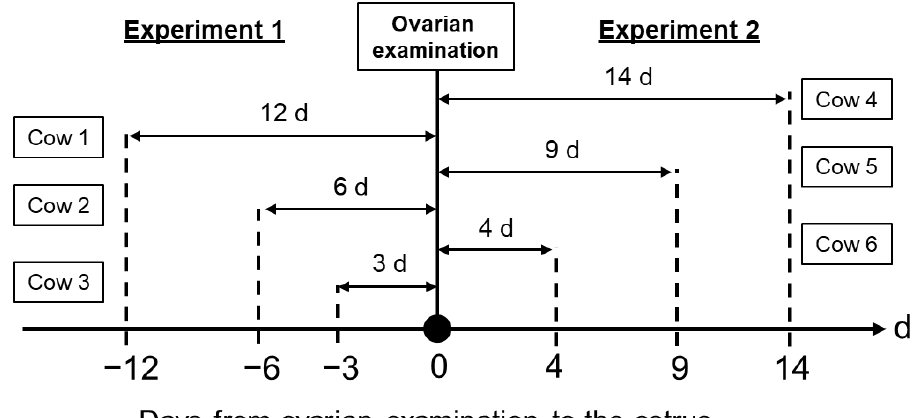
Figure 2. Schematic diagram of the experimental model. We visited the farm once a week, every Saturday, to examine the ovaries in each cow. In experiment 1, the day of the latest estrus was recorded in each cow, and the days from the latest estrus to ovarian examination day (0 d) were calculated. For example, see the Experiment 1 part of Figure 2. We did ovarian examinations on cows 1, 2, and 3 at 0 d, and we recorded the size and number of CL and large follicles in each cow. If the cows had CL ≥ 20 mm and at least one follicle with 10 mm, we checked the day of the latest previous estrus in each cow. When estruses were confirmed 12, 6, and 3 days before ovarian examination in cows 1, 2, and 3, respectively, we determined the days of the estrous cycle as 12, 6, and 3 days in cows 1, 2, and 3, respectively. In experiment 2, the day of the estrus during the 24 days after the ovarian examination was recorded in each cow, and the days from the ovarian examination day to the estrus were calculated. For example, see the Experiment 2 part of Figure 2. We did ovarian examinations of cows 4, 5, and 6 at 0 d, and we recorded the size and number of CL and large follicles in each cow. If the cows had CL ≥ 20 mm and at least one follicle with 10 mm, we would wait for the day of next estrus in each cow after the ovarian examination day. When estruses were detected 14, 9, and 4 days after ovarian examination in cows 4, 5, and 6, respectively, we evaluated the days between ovarian examination and the next estrus expression day in each cow. Ovarian examinations were performed by ultrasonography equipped with a 7.5 MHz linear transducer. We defined the functional corpus luteum (CL) as ≥ 20 mm and the large follicle as ≥ 10 mm, and we recorded the functional CL and large follicle numbers on the ovarian examination day.